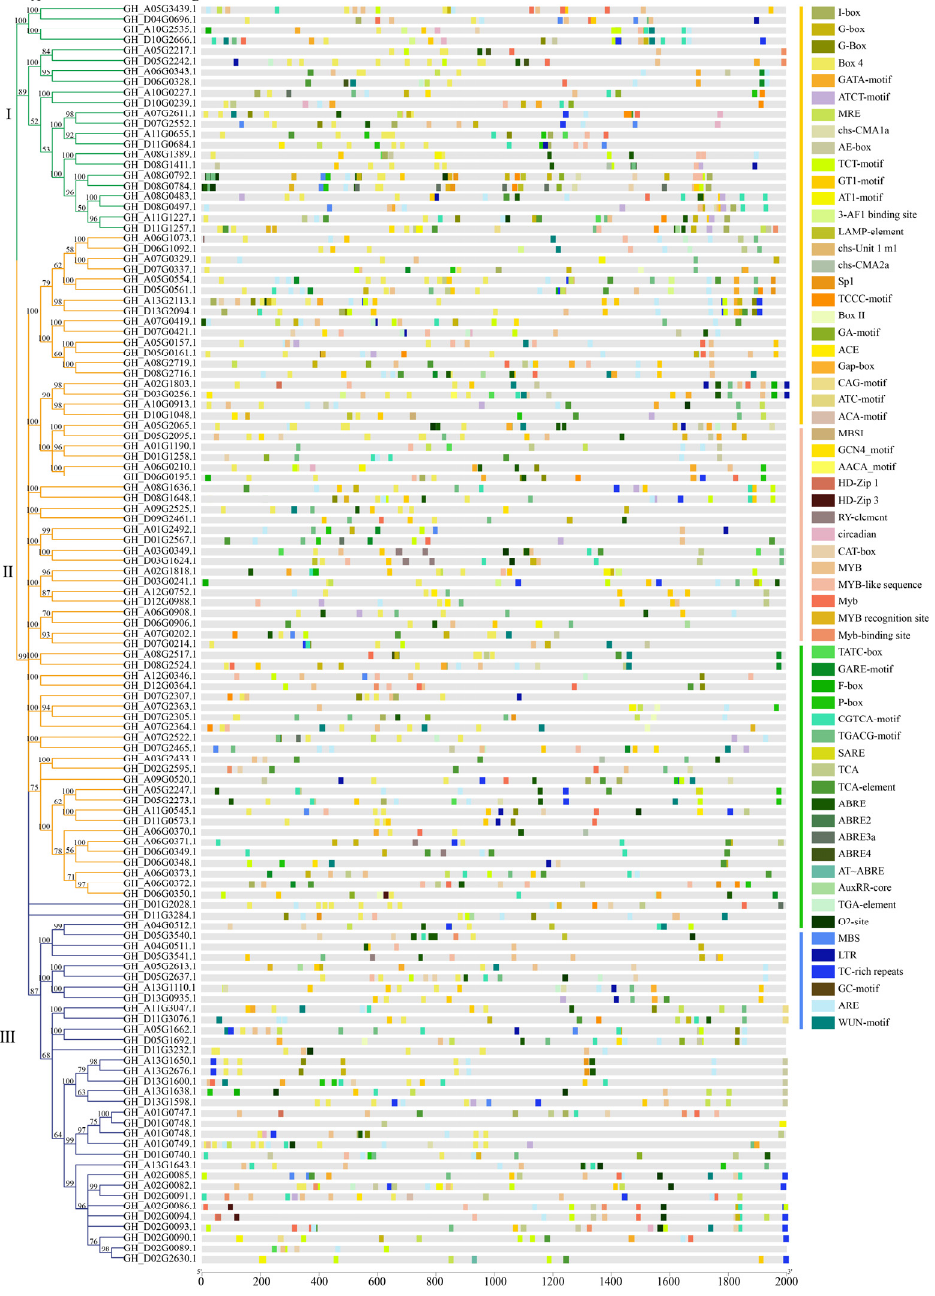
Figure 6. Analysis of cis-elements in promoter regions of GhFBXLs. ( A ) Phylogenetic tree of GhFBXL genes. ( B ) Analysis of cis-elements in GhFBXL s promoters. (I: Grpup I; II:Group II; III: Group III)